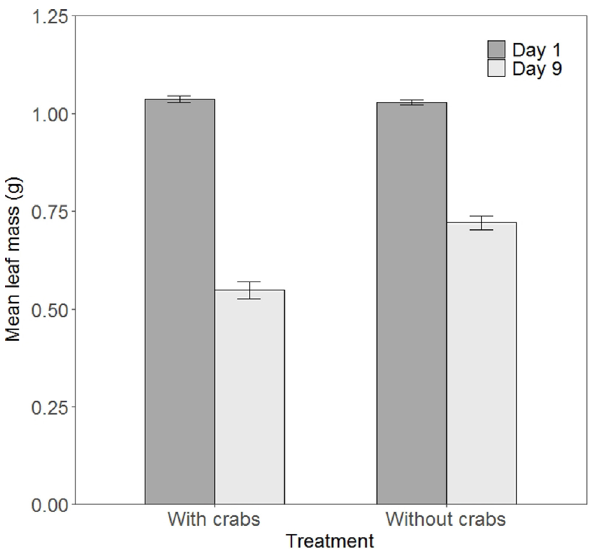
Figure 1. Mean leaf mass remaining in tanks with and without ( i.e. , leaves only) crabs, Ptychophallus tumimanus, on days one and nine. Depicted are means with standard error (± SE). There was a statistically significant difference of 0.18 g (95% CI: 0.13–0.23 g) of leaf mass loss in tanks with and without crabs (t (26) = 7.36, p < 0.001).